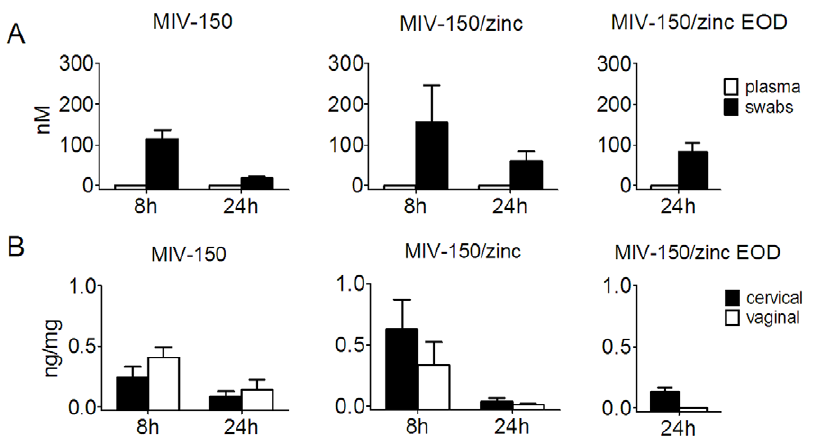
Figure 3. MIV-150 does not accumulate systemically after repeated application. Animals were treated with 50 m M MIV-150 (PC-815) or 50 m M MIV-150/14 mM zinc acetate dihydrate (PC-1005) daily for 2 weeks (daily) or with 50 m M MIV-150/14 mM zinc acetate dihydrate every other day for 4 weeks (EOD). (A) Plasma and vaginal swabs and (B) cervical and vaginal tissues were collected 8 or 24 h after the last gel and the levels of MIV-150 measured by RIA. The mean concentrations ( 6 SEM, n=6) of MIV-150 for each treatment group are